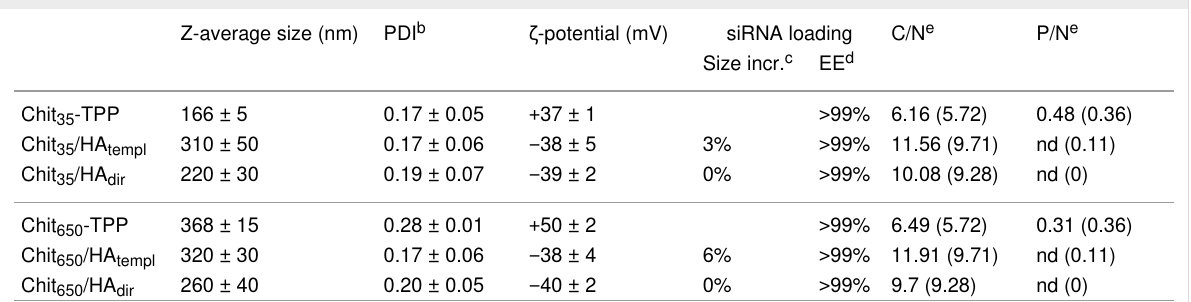
Table 1: Physico-chemical characterization of the nanoparticles a